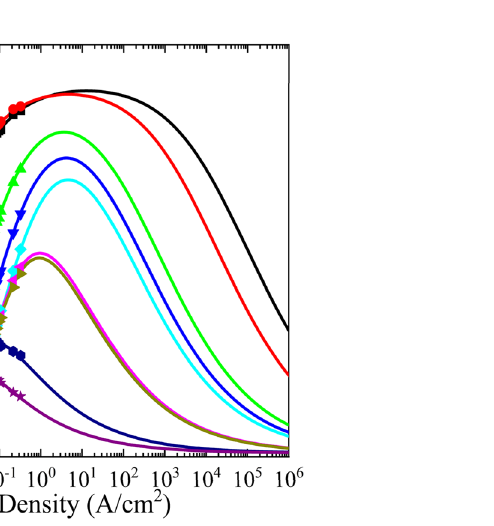
Figure 2. The EL spectra of the AlGaAs/GaAs DH is measured at a current density of 0.325A/cm 2 for different temepratures.